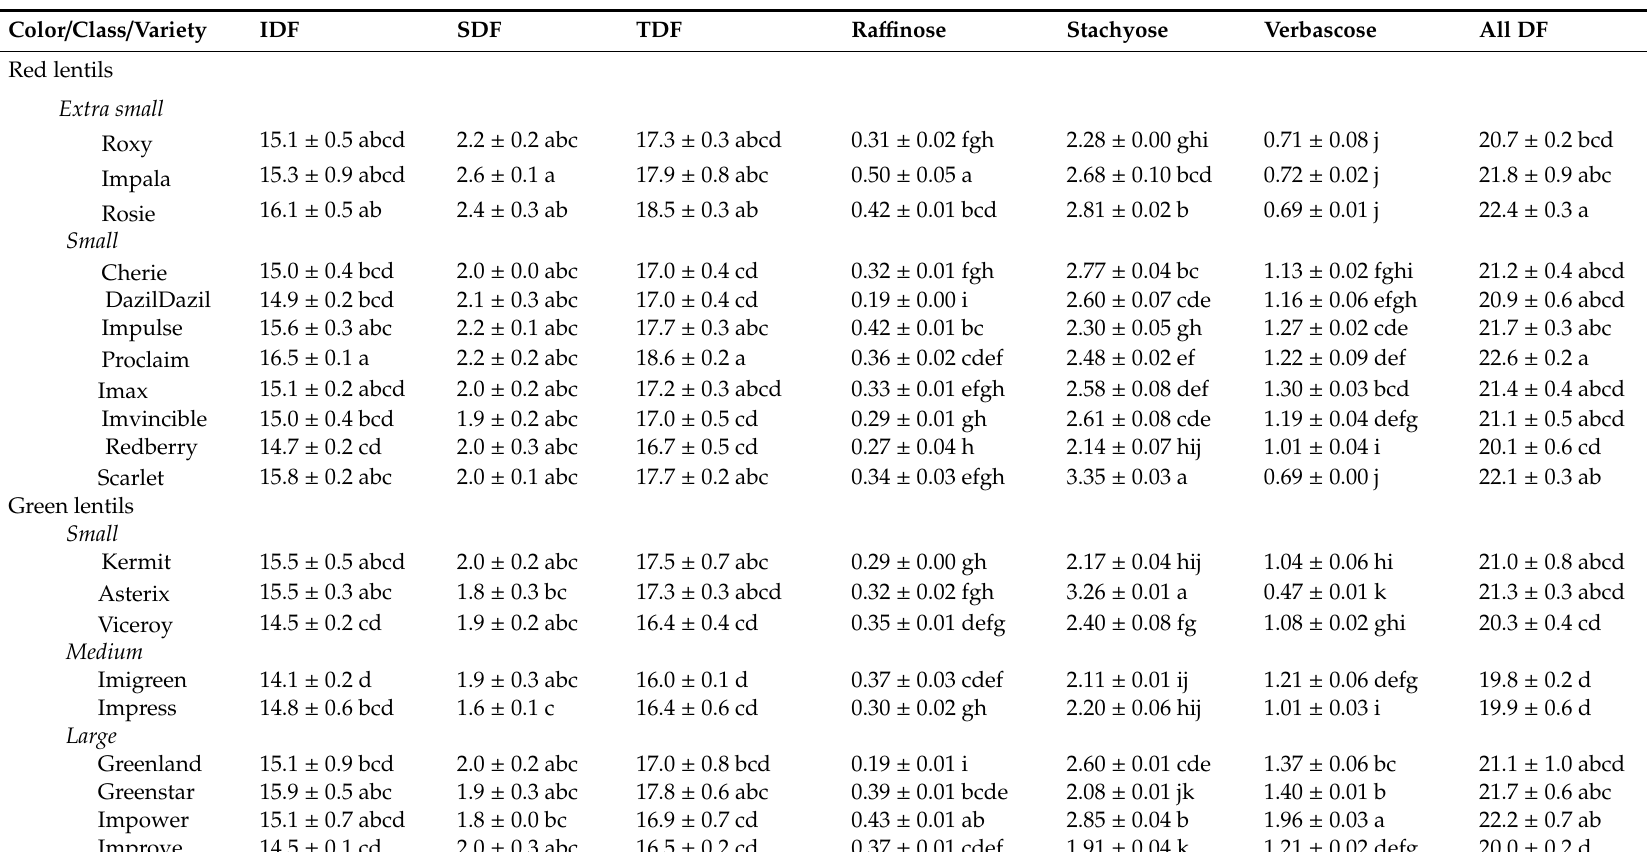
Table 2. Dietary fiber and galacto-oligosaccharides content of freeze-dried cooked lentil powders (%, dry weight